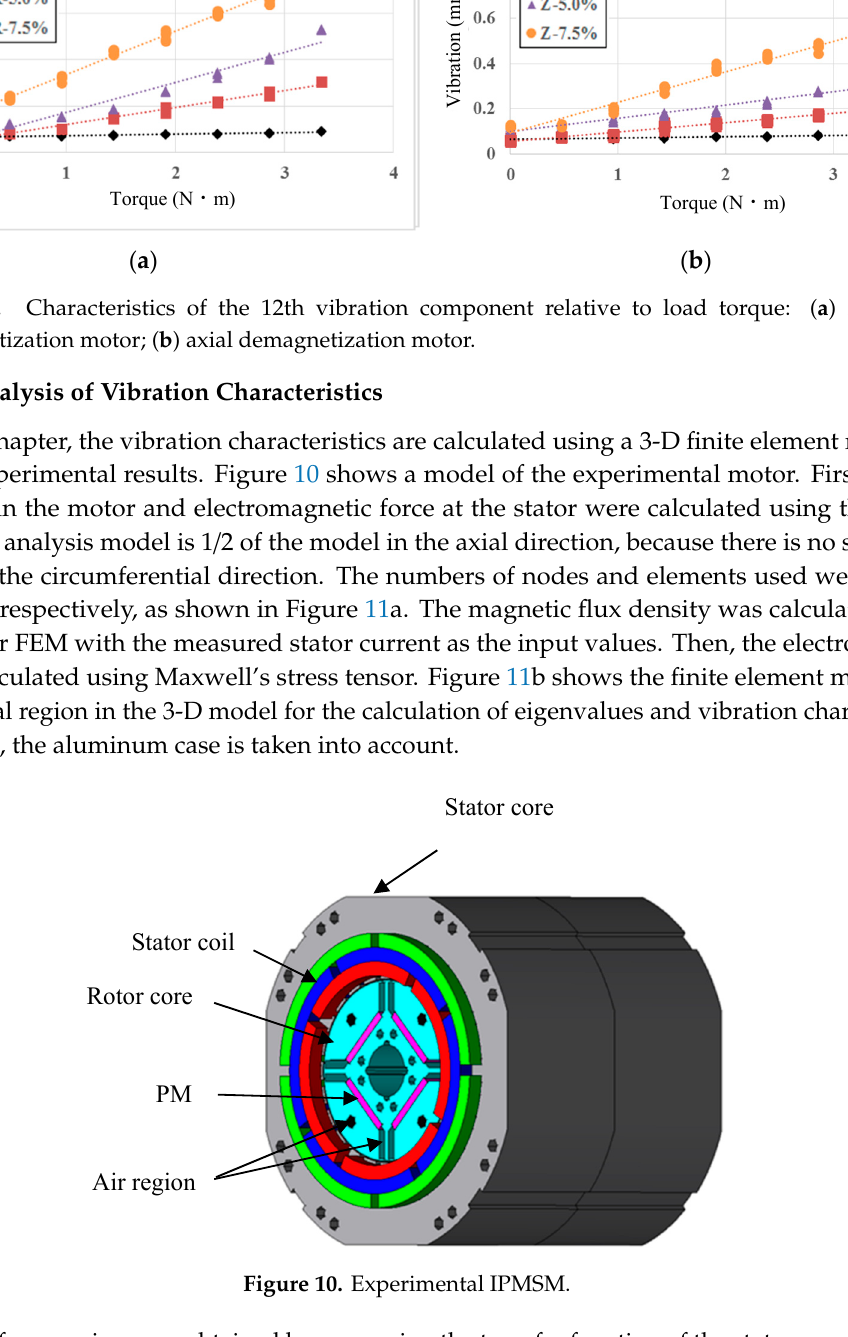
( b ) Figure 11. Finite element mesh of the cross-sectional region in the 3D model: ( a ) for electromagnetic field calculation; ( b ) for vibration calculation considering aluminum case. Natural frequencies were obtained by measuring the transfer function of the stator core. A PV08A piezoelectric accelerometer was attached to the top of the stator and was connected to one channel of a UV-06 charge amplifier. A PH-51 impulse hammer was connected to the other channel. The charge amplifier was connected to a SA-01A4 signal analyzer and then to a PC where software for the SA-01A4 was installed. The transfer function was measured by hammering the stator surface. Table 2 shows the six lowest measured natural frequencies compared with the calculated ones. The relative error of the natural frequencies was in the range of 10% through 15%. Table 2. Natural frequencies. Measured (Hz)